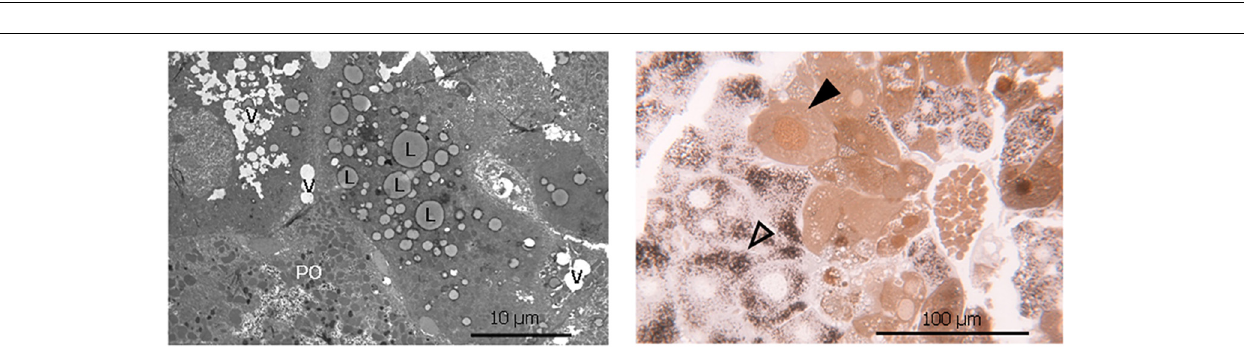
FIGURE 4 | Hepatic steatosis in phytol challenged PMP34 knockout mice. Liver sections of male control (WT) and knockout (KO) mice fed standard or phytol enriched diet were stained with Oil red O (ORO) ( top row; scale bar 50 µ m) or immunostained for macrophage marker F4/80 plus DAPI (second row; scale bar 200 µ m; inset scale bar 25 µ m), showing in the liver of the KO mice fed phytol accumulation of neutral lipids or enlarged macrophages in the process of phagocytosing cell debris (asterisks). Bottom , left: representative TLC of lipid extracts of liver of male age-matched WT and KO mice fed standard or phytol diet, visualized by iodine staining (solvent hexane/diethylether/acetic acid 70/30/1, v/v; portion of plate shown; direction of solvent indicated by arrow and its front by F). Standards, migration indicated, were cholesterol (C), triolein (triacylglycerides, TAG), cholesteryloleate (cholesterylester, CE); X indicates presence of new TAG species. When using hexane/diethylether/acetic acid (80/20/1, v/v) as solvent, spot X is splitting up in separate bands (right panel).